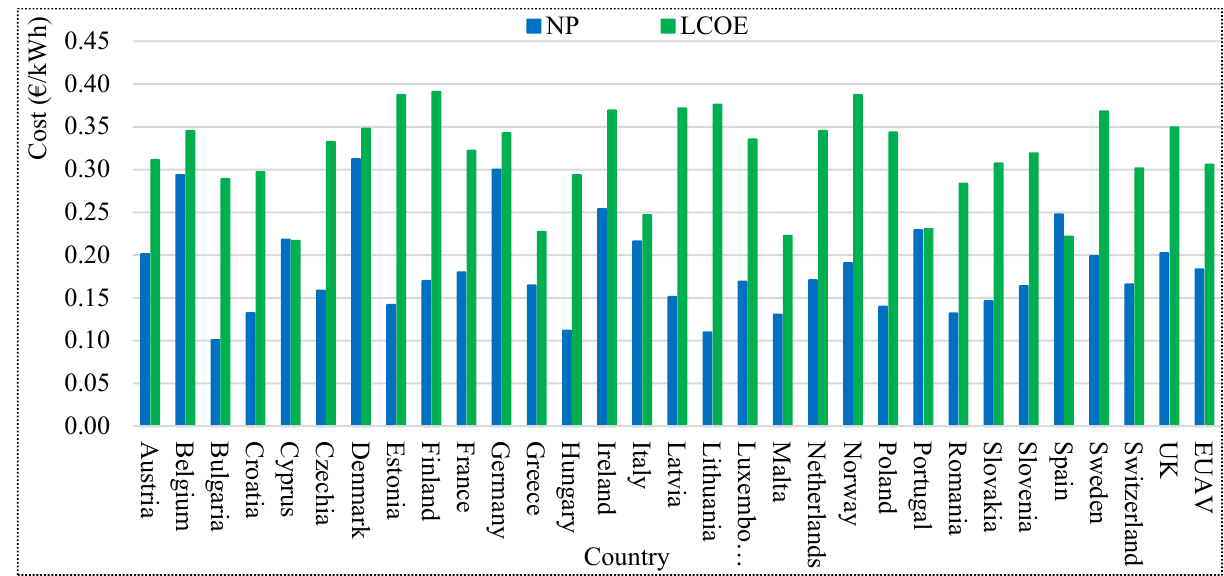
Figure 7. BIPV net present value of environmental benefits.